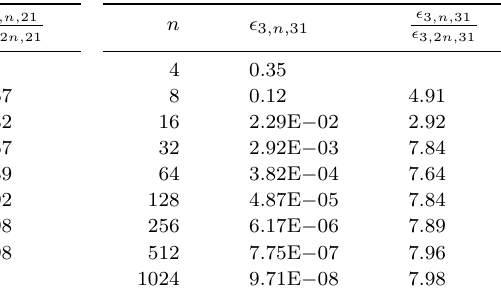
Table 7. m = 2, p = 21, λ 0 = 0 . 2, λ 1 = 0 . 9. Table 8. m = 3, p = 31, λ 0 = 0 . 2, λ 1 = 0 .